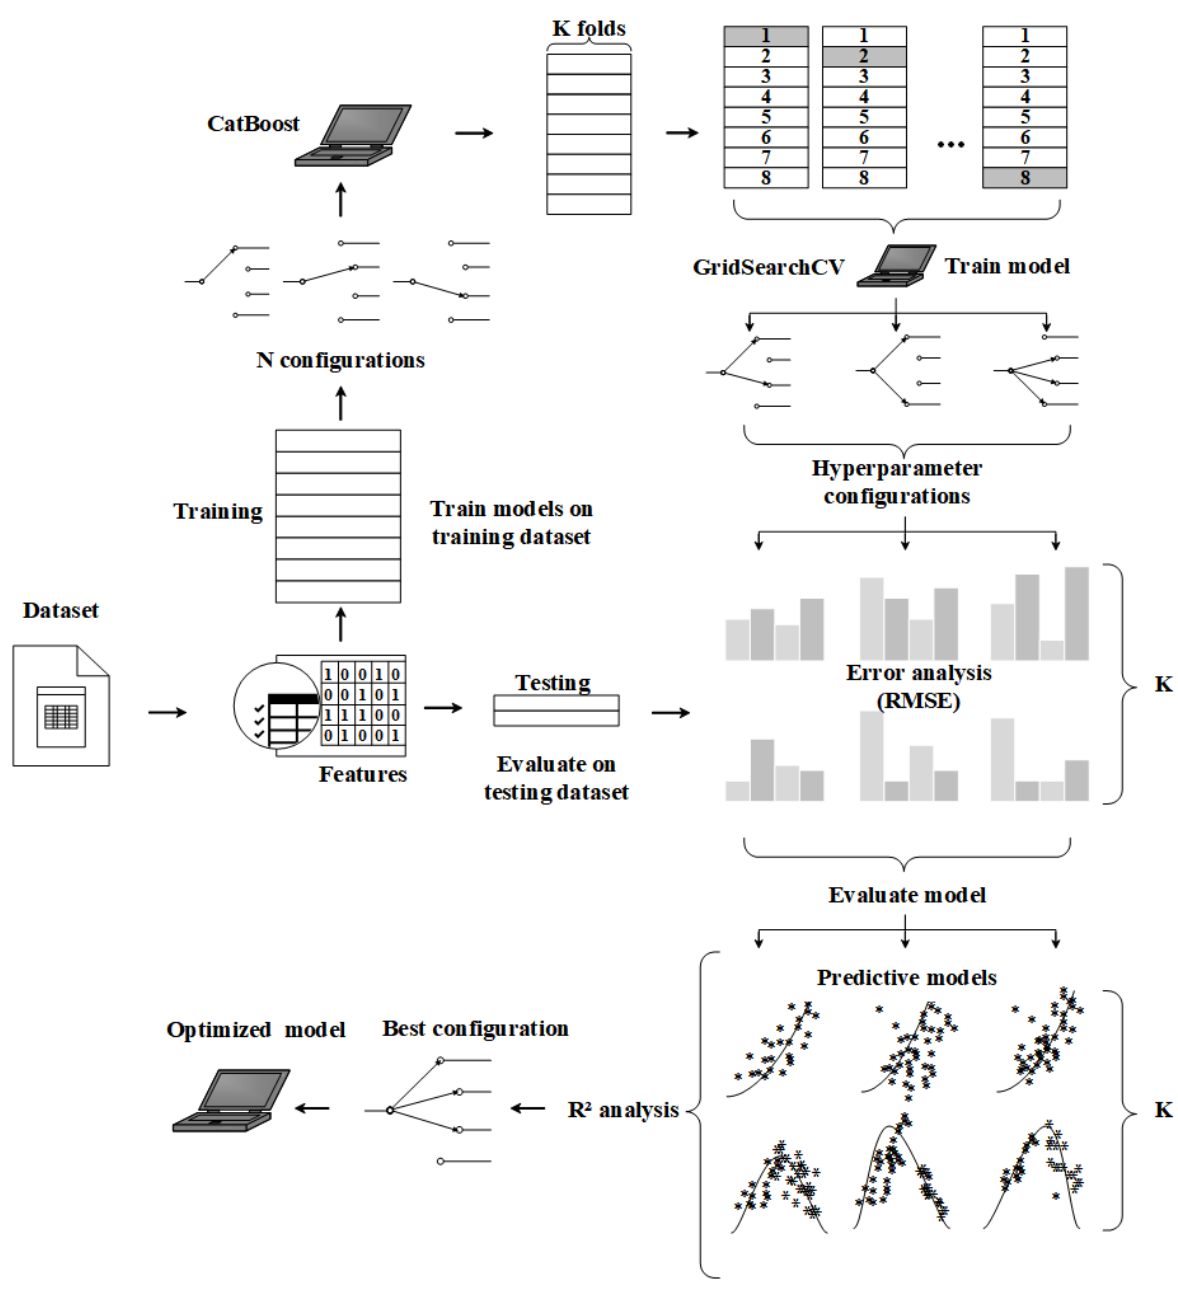
Figure 3. The schematic figure of the analysis pipeline showing the integrated algorithmic regression and evaluation mechanism.